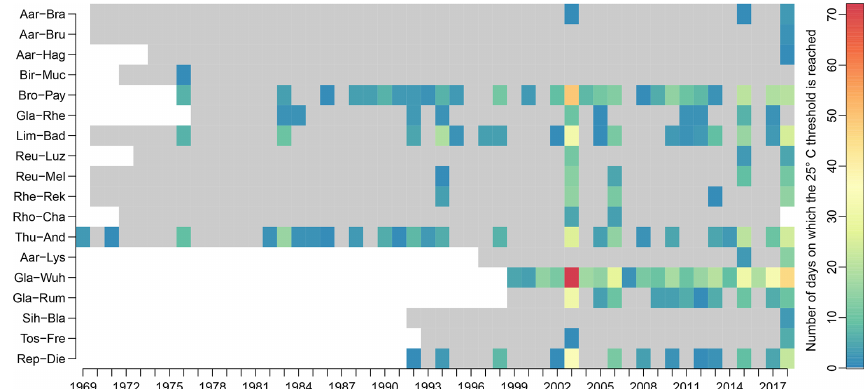
Figure 13. Number of days per year when the 25 ◦ C threshold is reached (i.e. water temperature is above 25 ◦ C for at least 1h during the specific day). Only catchments where the threshold is reached at least once are shown. Abbreviations of catchments names are explained